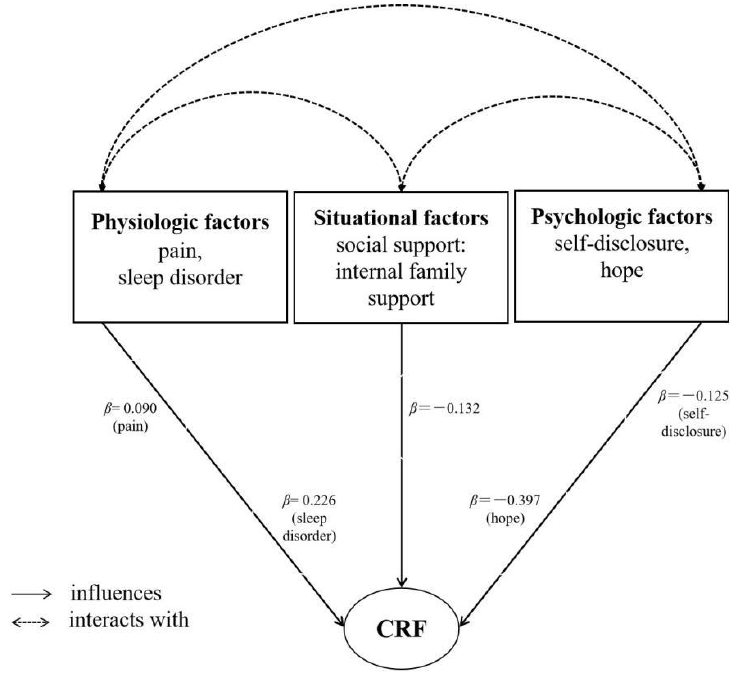
Figure 4. The model on modifiable influencing factors of CRF in patients with colorectal cancer. Notes: CRF, cancer-related fatigue; β , standardized coefficient.